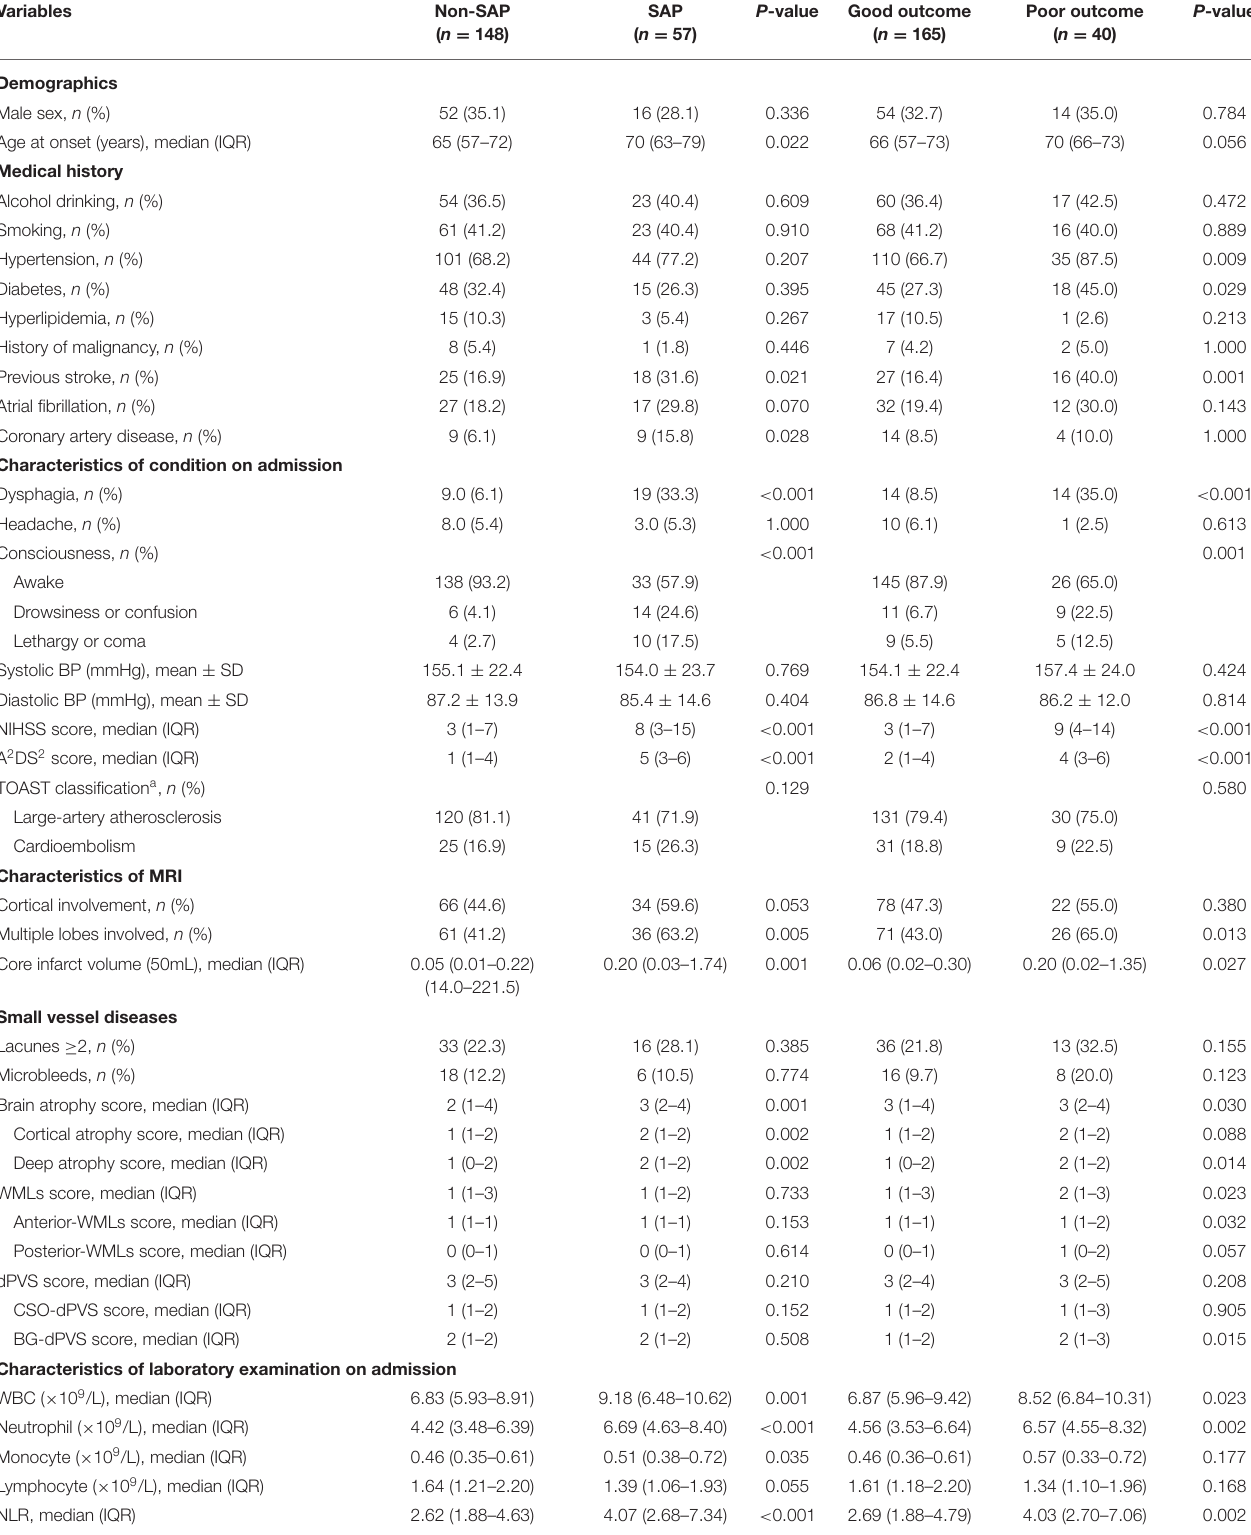
TABLE 1 | Univariable analysis of baseline characteristics associated with occurrence of SAP and development of poor outcome.